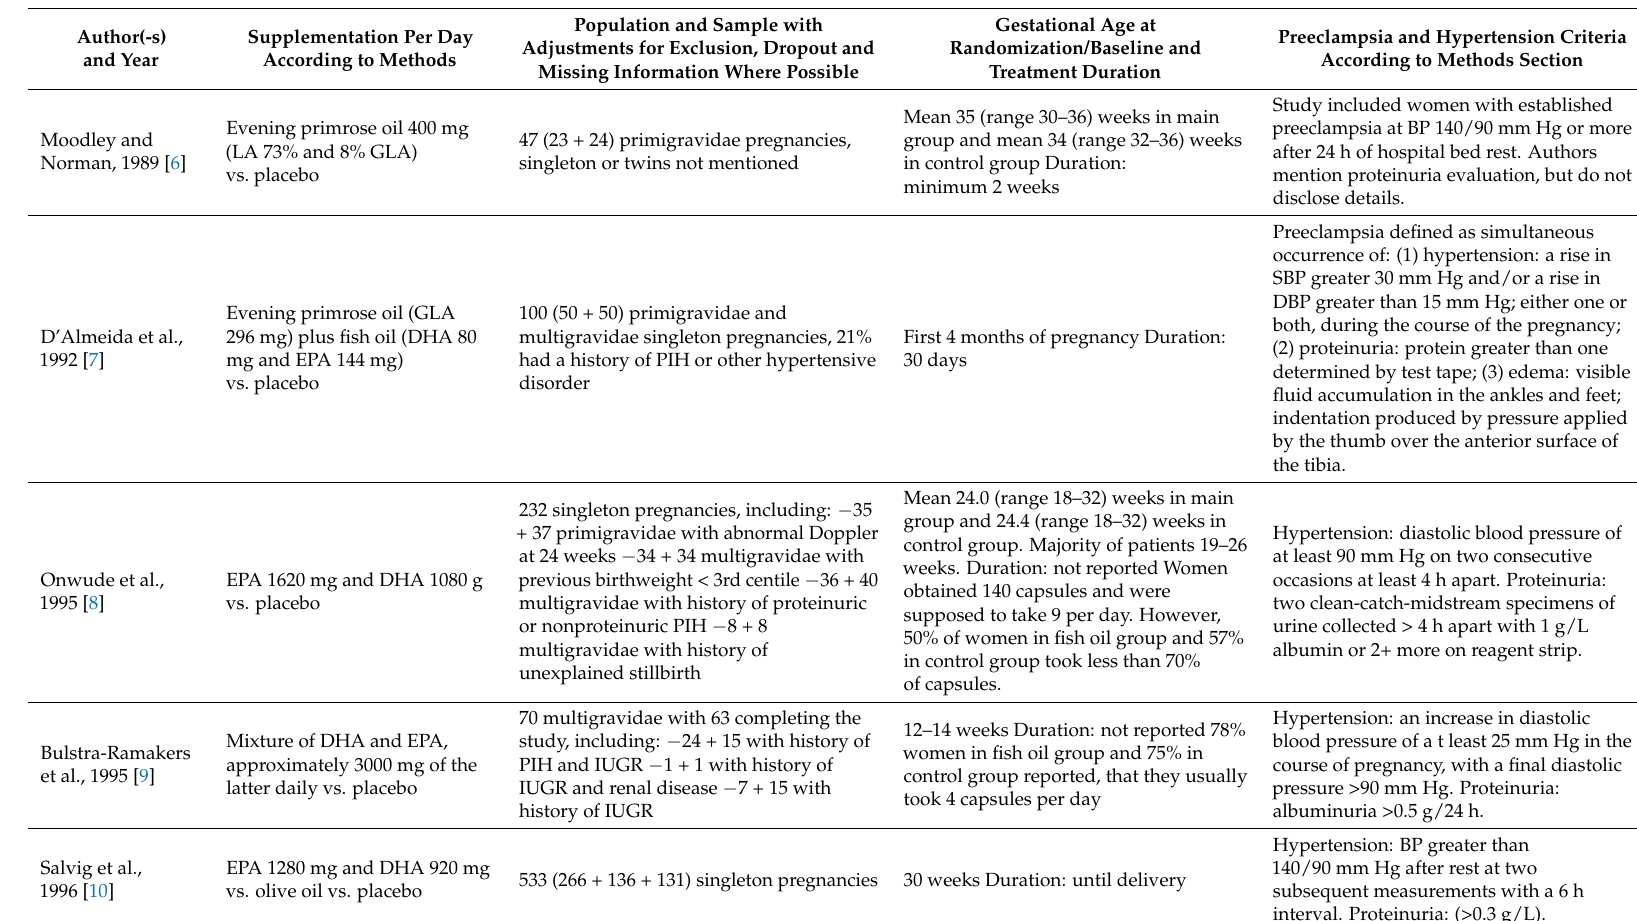
Table 1. Randomized studies of omega-3 supplementation and hypertensive disorders of